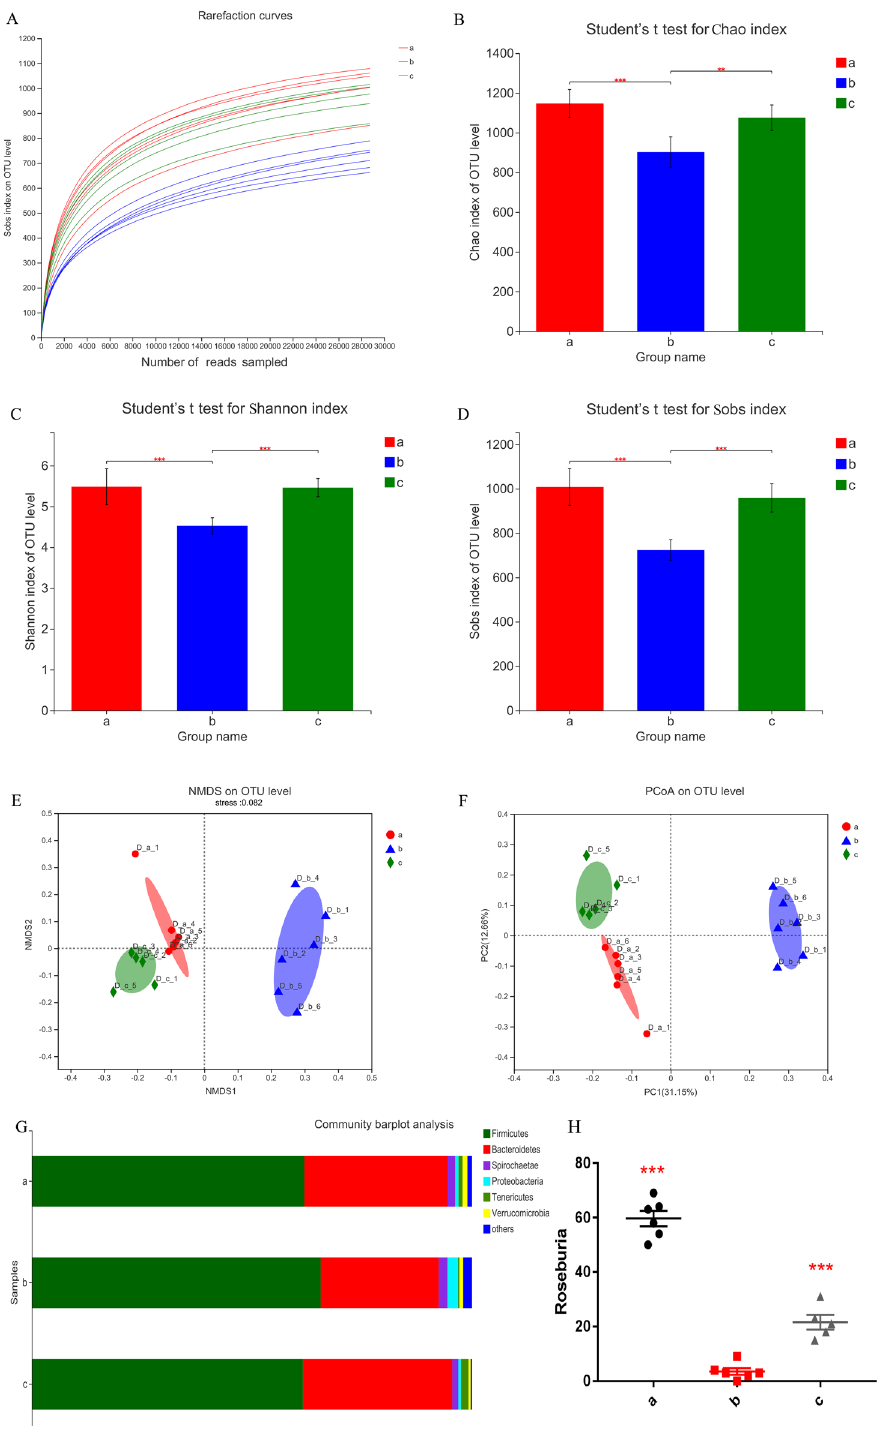
Figure 5. ( A ) Faecal sample rarefaction curves. ( B ) The Chao estimator of camel faecal flora in different dietary stages. ( C ) The Shannon diversity index of camel faecal flora in different dietary stages. ( D ) The observed richness (Sobs) of camel faecal flora in different dietary stages. Statistical analysis was performed by one-way ANOVA with Tukey’s multiple comparison post-test, *0.01 < P ≤ 0.05, ** 0.001 < P ≤ 0.01, *** P ≤ 0.001. ( E ) Nonmetric multidimensional scaling (NMDS) ordination plots of faecal bacterial communities. ( F ) Principal coordinate analysis of microbial community membership. ( G ) Faecal microbial composition at the phylum level. ( H ) Richness of Roseburia in the faeces of Bactrian camels. Statistical analysis was performed by one-way ANOVA with Tukey’s multiple comparison post-test (* p < 0.05, ** p < 0.01, *** p < 0.001). a: Feeding period, b: fasting period, c: recovery feeding